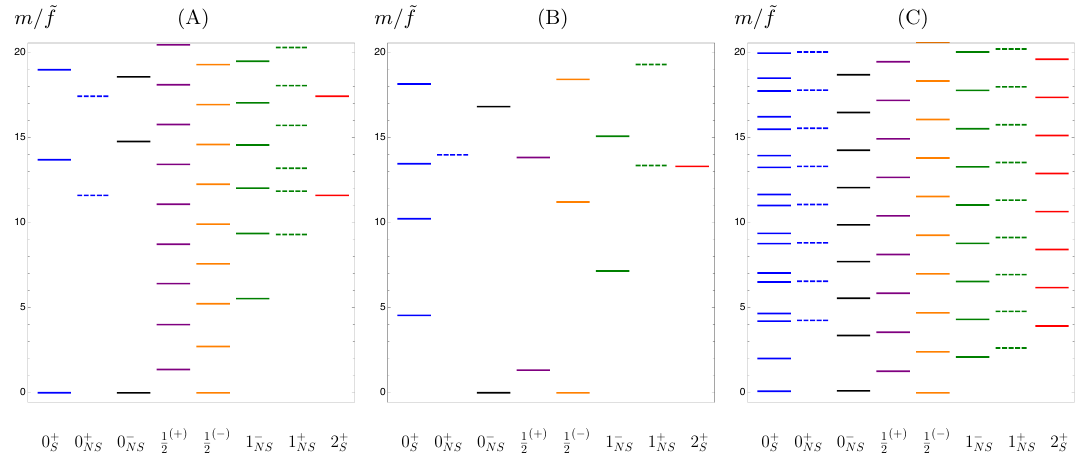
Figure 24 . Bosonic and fermionic spectra for three especial scenarios described in the text. Scenario (A) corresponds to Model I with ∆ = 2 . 5 , x F = 4 . 6 , g 5 = 8 , ∆ R = 2 . 5 , r 1 = 10 − 16 (bosons), r 1 = 10 − 30 (fermions), r 2 = 15 . The remaining two scenarios correspond to Model II with ∆ = 3 , x F = 1 , g 5 = 8 , ∆ R = 2 . 5 , r 1 = 10 − 12 , r 2 = 15 . In addition, for scenario (B) we took ∆ φ = 1 , φ c = 1 . 5 , y 5 = − 2 , and for scenario (C) ∆ φ = 0 . 2 , φ c = 3 . 7 , y 5 = 0 . All plots are normalised in units of the decay constant ˜ f . Below the plots, we indicated by J P the spin J and parity P of S,NS the various bosonic states, as well as whether they transform in singlet ( S ) or non-singlet ( NS ) flavour representations. For the fermionic states, J = 1 / 2 , the superscripts (+) and ( − ) refer to the choice of the IR boundary condition, corresponding to the composite sector being vector-like or chiral, respectively. The various sectors from left to right are: singlet scalar (blue, solid lines), non-singlet scalar (blue, dashed lines), non-singlet pseudoscalar (black, solid lines), fermion in the vector-like case (purple, solid lines), fermion in the chiral case (orange, solid lines), non-singlet vector (green, solid lines), non-singlet axial-vector (green, dashed lines), singlet tensor (red, solid lines). The non-singlet scalar spectrum is computed using the invariant I 2 (for details see [1]).